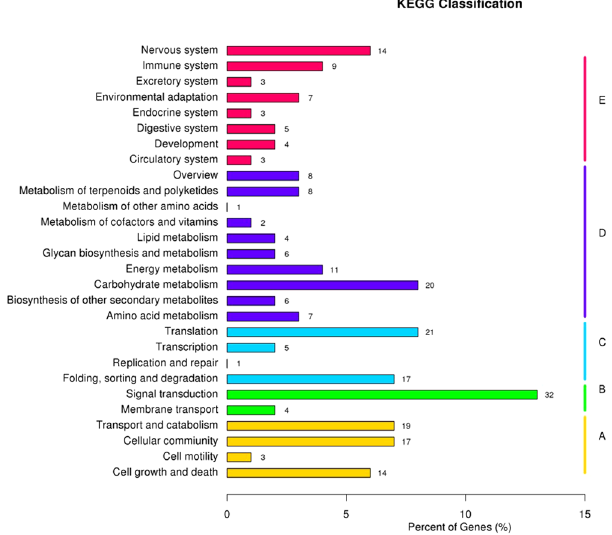
Figure 7. The KEGG classification of miRNA targets. These miRNA targets are predicted by computational program described in the method section. The majority of miRNA targets have been confirmed experimentally in previous reports. These classification includes cellular processes ( A ), environmental information processing ( B ), genetic information processing ( C ), metabolism ( D ) and organismal system ( E